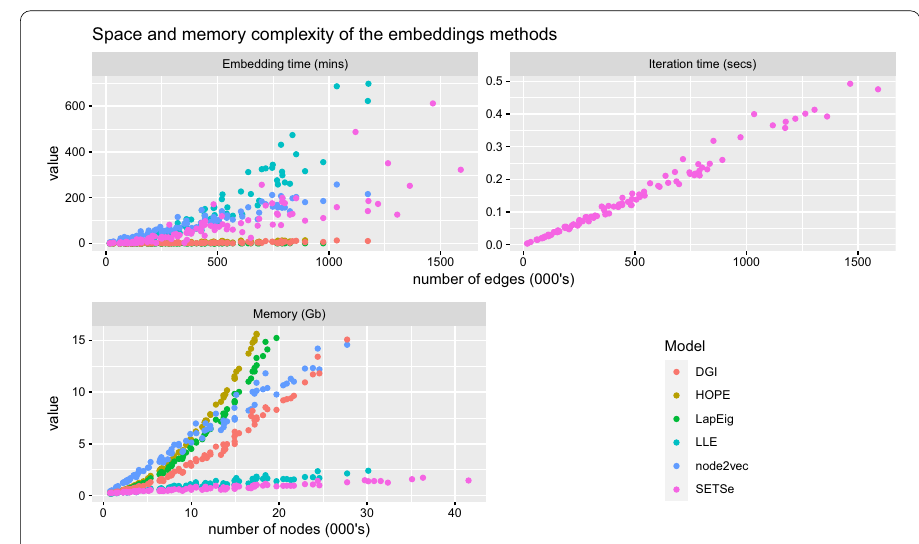
Fig. 10 The per-iteration complexity is linear for SETSe; however, the complexity of the total time to convergence is closer to quadratic. Memory complexity is linear and substantially lower than in the other